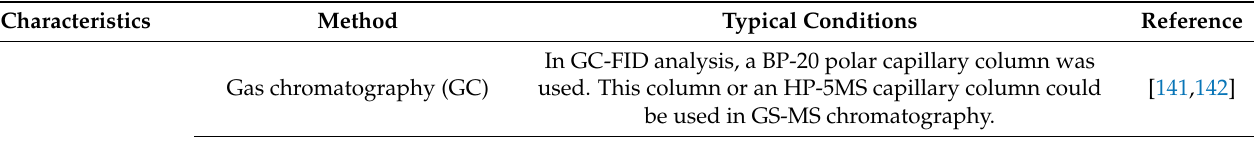
Table 5. Techniques for PHA polymer